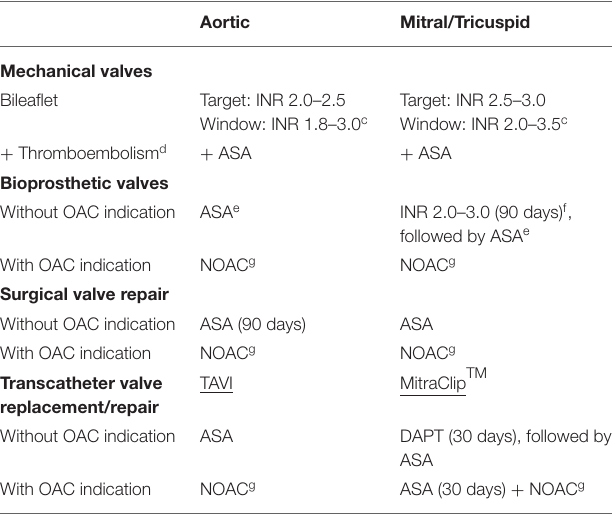
TABLE 2 | University Hospitals Leuven consensus on antithrombotic treatment after heart valve repair and replacement a, b . Aortic